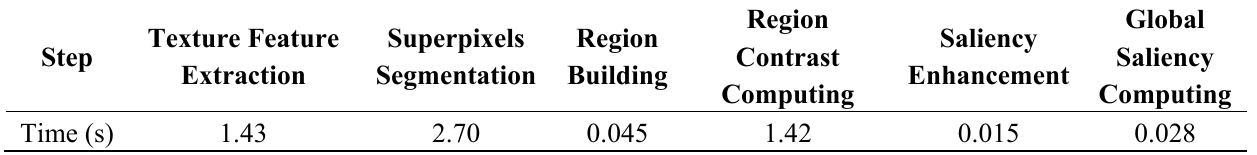
Table 3. The time required for each step of our method on average.